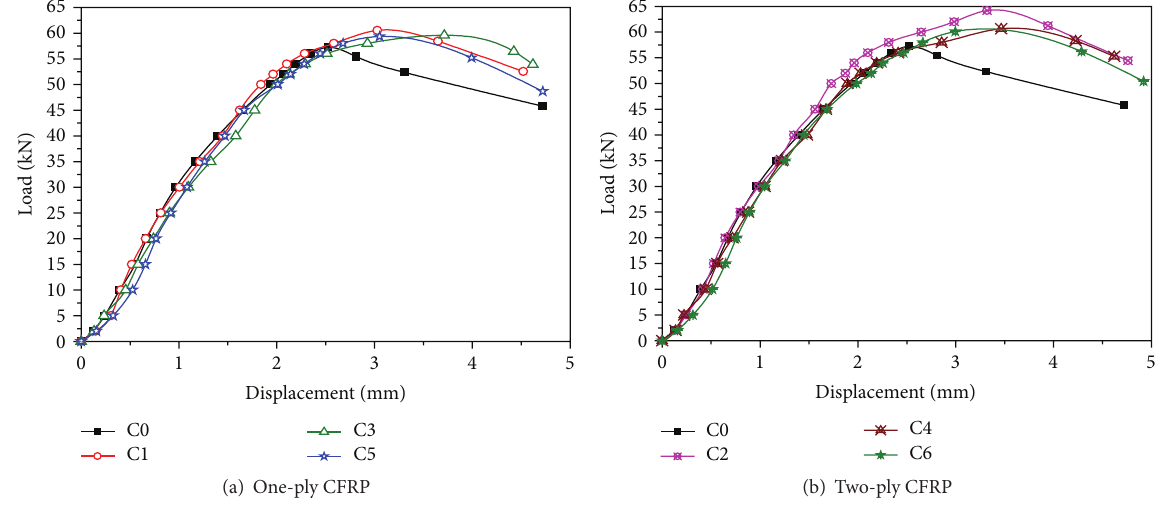
Figure 6: Web load-deformation curves.